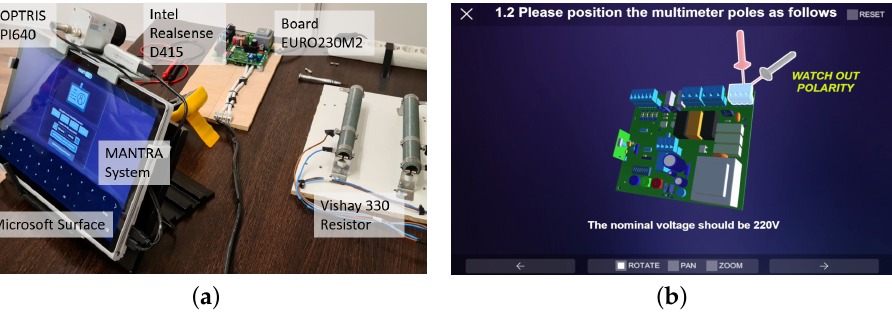
Figure 10. ( a ) Use-Case setup. ( b ) GUI